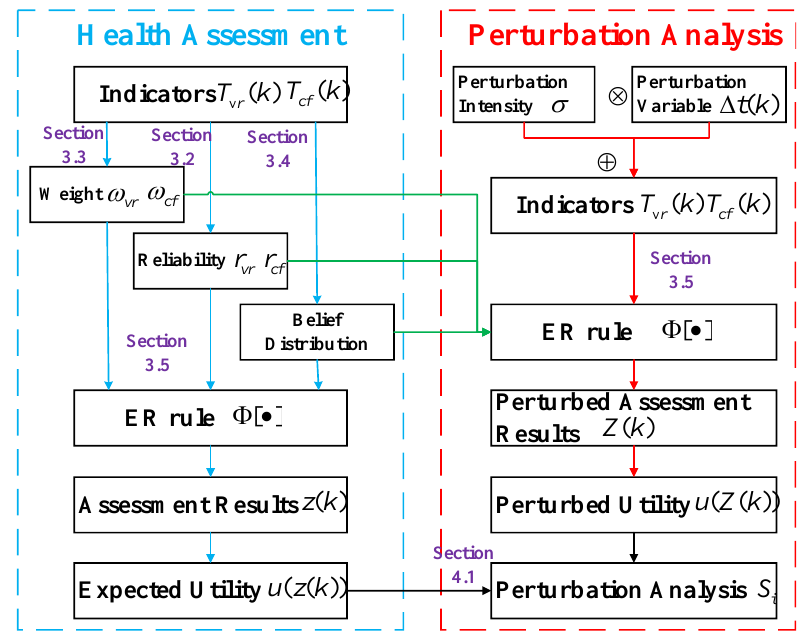
Figure 4. Mo del’s overall analysis process. Figure 4. Model’s overall analysis process.